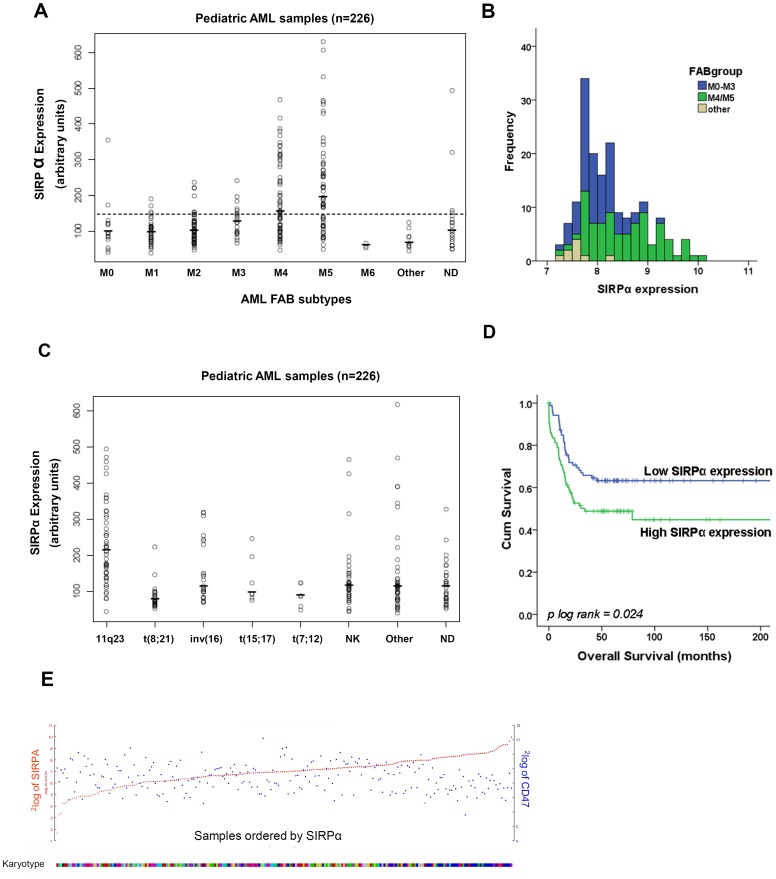
SIRPα mRNA expression and its prognostic effect in pediatric AML cohort.(A) SIRPα mRNA expression was determined in different FAB subtypes. The dots represent individual patients and the horizontal bar is the group mean. The horizontal dotted line represents the mean levels (139.6; n = 5) of SIRPα expression in normal CD34+ HSC. (ND: not determined). (B) Frequency of SIRPα expression among different FAB subtypes of AML patients is shown as stacked histograms. (C) SIRPα mRNA expression as stratified after karyotype (NK: normal karyotype). (D) Overall survival of pediatric AML patients (n = 175) stratified according to either low (< median of 8.1) or high (≥ median 8.1) SIRPα mRNA expression. (E) Correlation between CD47 and SIRPα mRNA expression is shown by the blue and red dots, respectively. The lower bar demonstrates the cluster of patients in karyotypes, in which higher SIRPα expression is clustered in blue, representing the MLL rearrangement group on the right side.